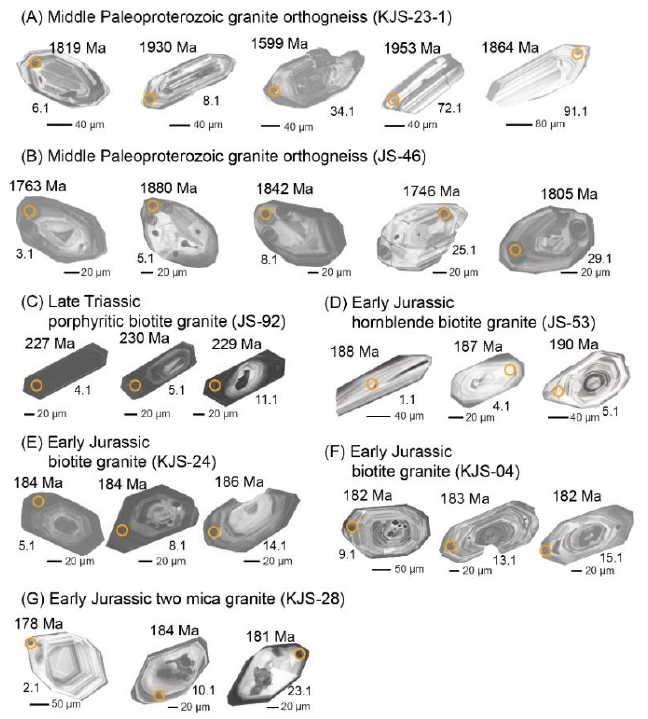
Figure 4 . Scanning electron microscope (SEM) cathodoluminescence images of sectioned zircon grains from ( A , B ) Middle Paleoproterozoic granite orthogneisses, ( C ) Late Triassic porphyritic biotite granite, ( D ) Early Jurassic hornblende-biotite granite, ( E , F ) Early Jurassic biotite granites, and ( G ) Early Jurassic two mica granite in the Jangsu-gun area.